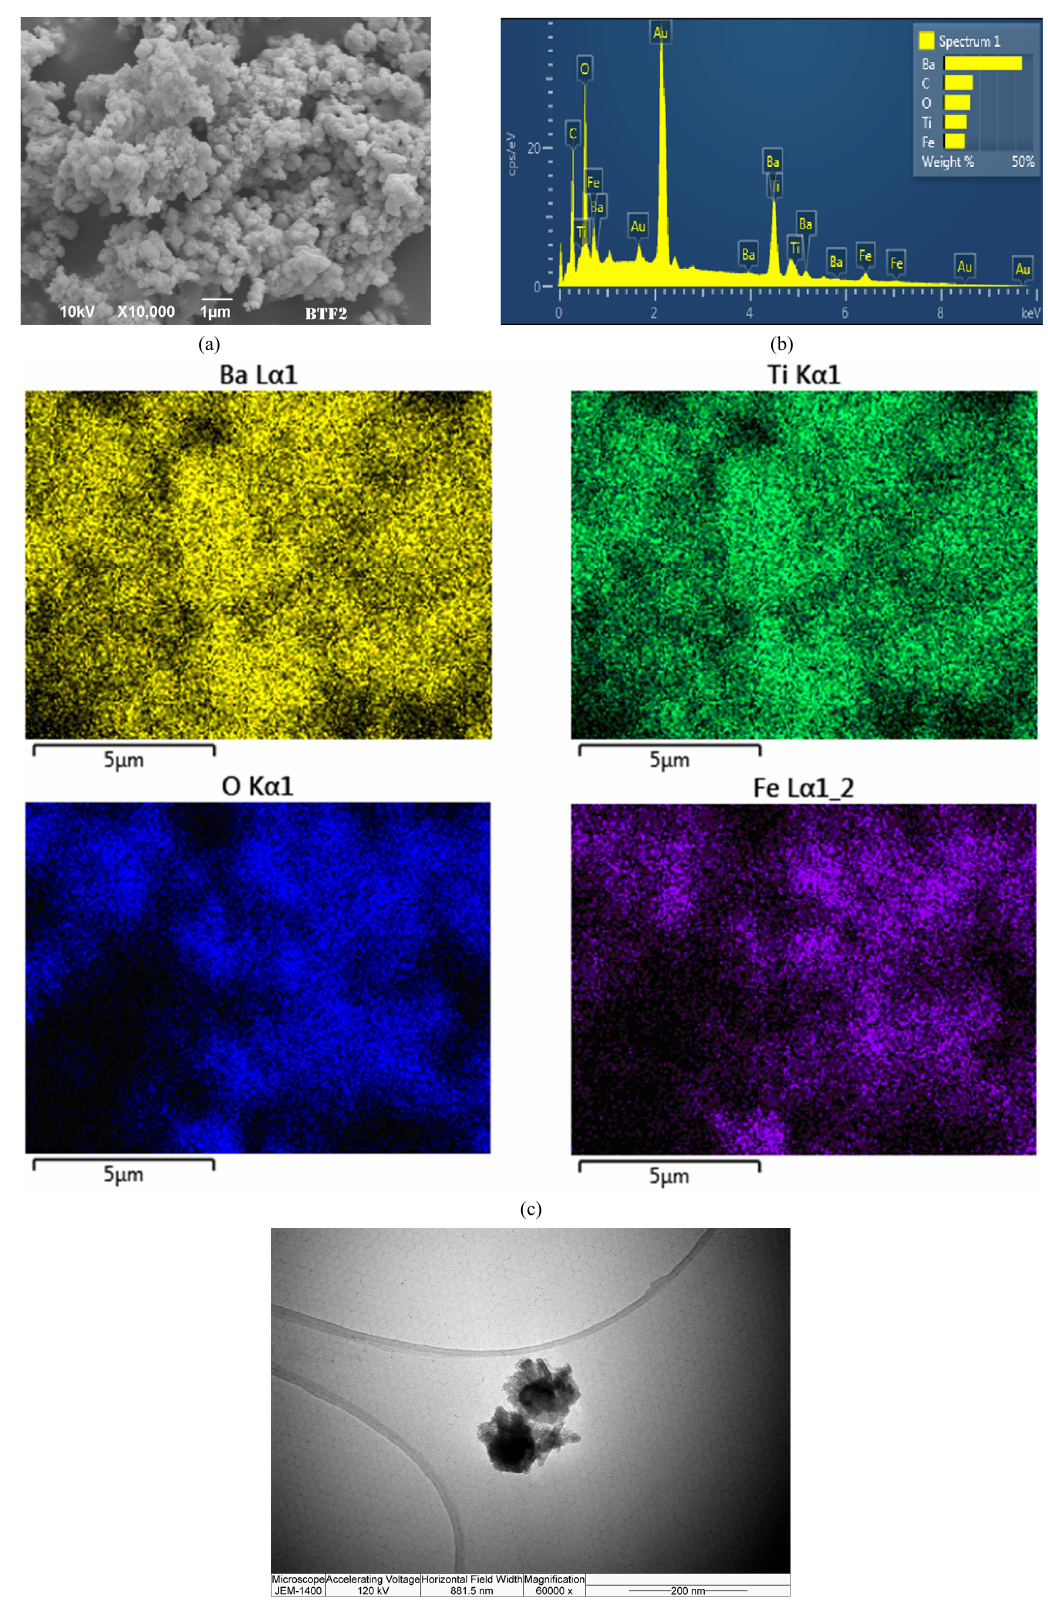
Fig. 5 (a) SEM; (b) EDS; (c) mapping of elements; (d) TEM for the sample